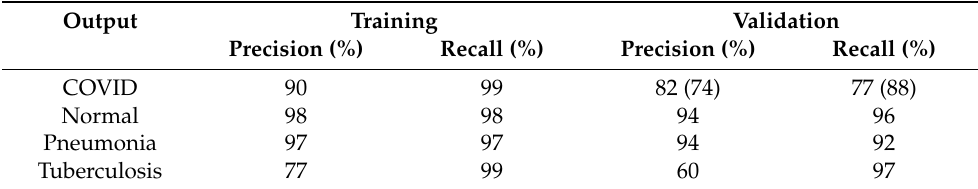
Table 3. CheXpert-COVID19 model: precision and recall on training and validation sets for the epoch 24 (and for epoch 26 for